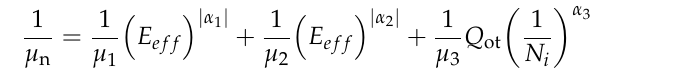
( b ) Figure 7. SEU cross-sections characterized by Bi ion versus layout structure for SOI SRAMs after deposition 800 krad(Si). The vertical column represents data for the “ 1 → 0 ” upset, the horizontal column represents data for the “ 0 → 1 ” upset. The data pattern applied during SEU testing is ( a ) 55h and ( b ) AAh. 4. Discussion